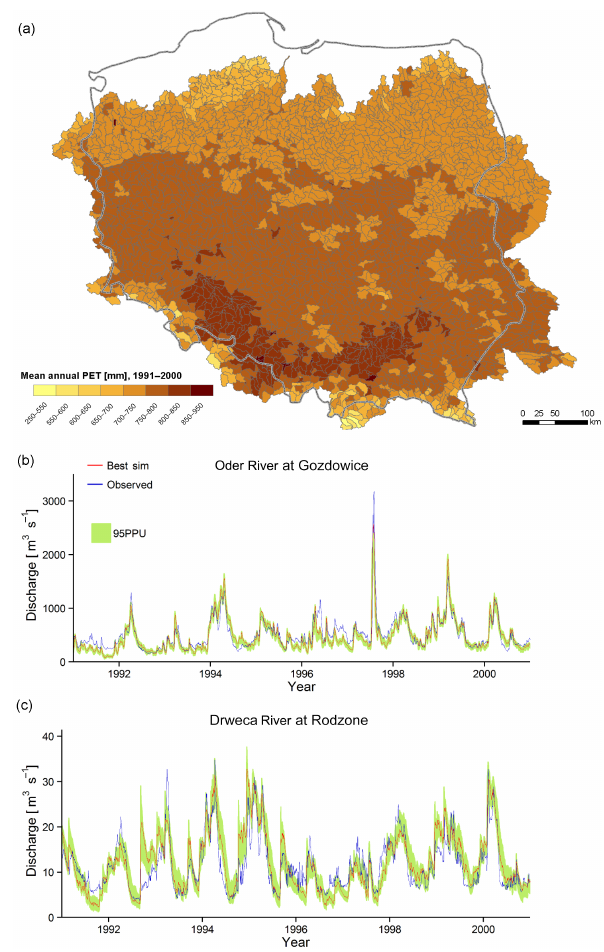
Figure 15. Example application of CPLFD-GDPT5 in the hydro- logical model SWAT of the Vistula and Oder basins. (a) Mean an- nual potential evapotranspiration calculated using the Hargreaves method based on daily minimum and maximum-temperature data. (b) Simulated and observed daily stream flow on the Oder River at Gozdowice gauging station. (c) Simulated and observed daily stream flow on the Drweca River at Rodzone gauging station. Green band denotes 95% prediction uncertainty; blue and red lines denote observed and simulated (best solution) flows,